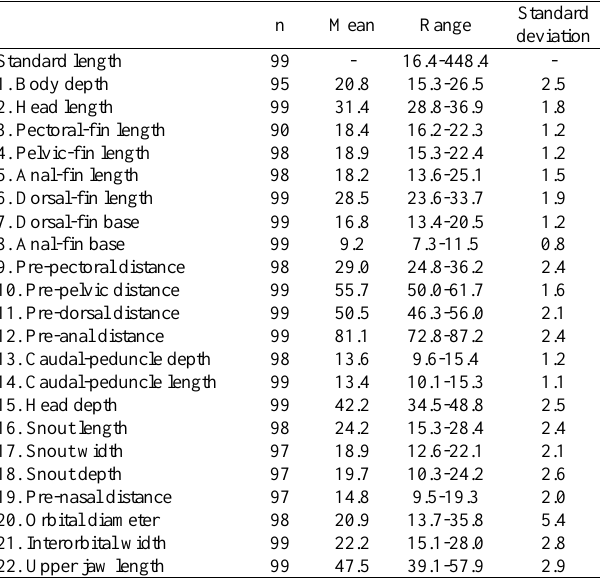
Table 6. Morphometric data of Hoplias intermedius . Standard length in mm; values 1-14 are percents of standard length and values 15-22 are percents of head length. n = number of examined